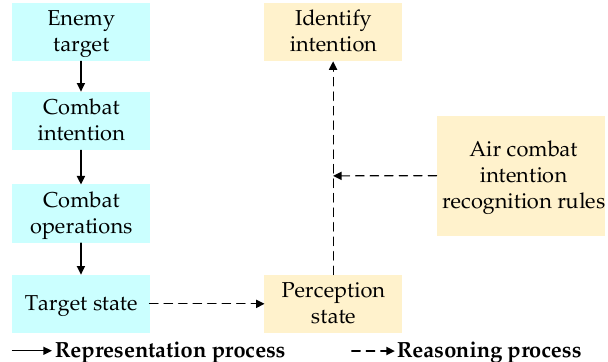
Figure 1. Hierarchical representation and reasoning process of intention .